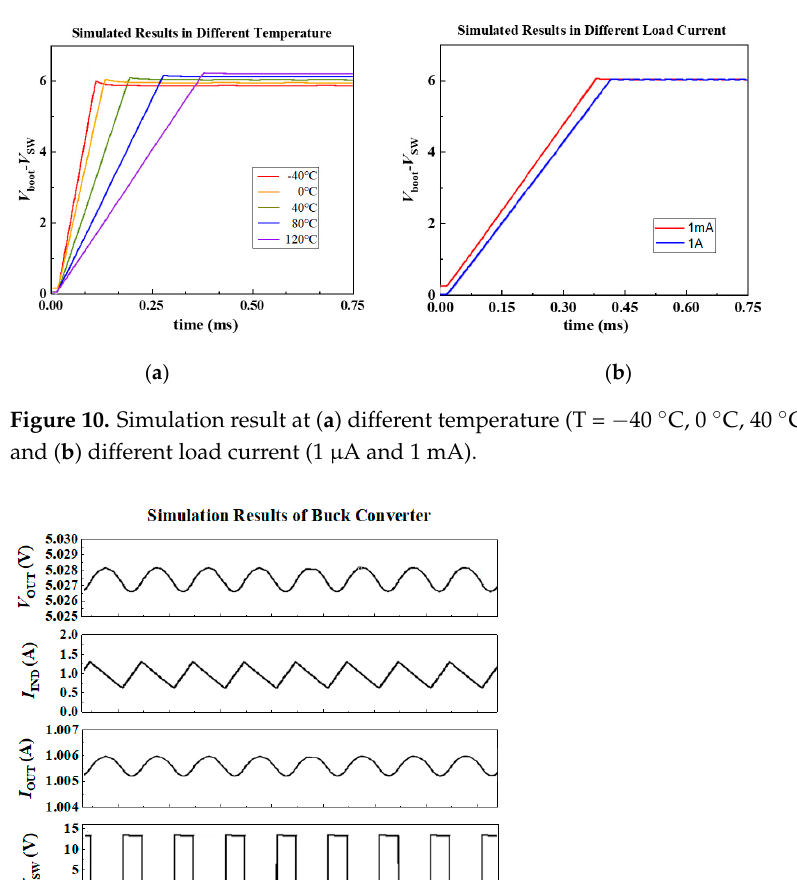
Figure 10. Simulation result at ( a ) different temperature (T = − 40 °C, 0 °C, 40 °C, 80 °C and 120 °C) and ( b ) different load current (1 µA and 1 mA).